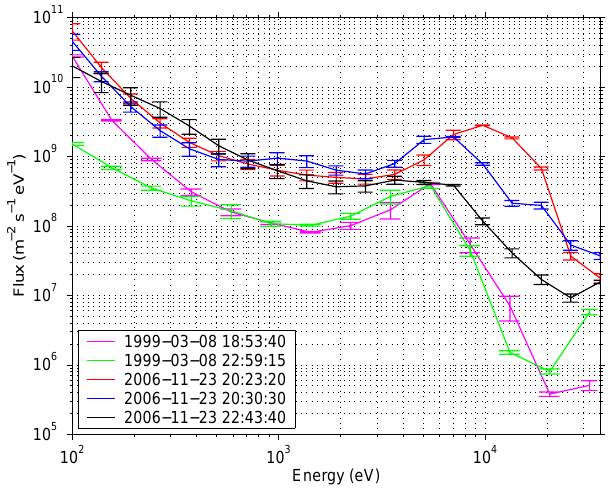
Fig. 5. Precipitating electron energy spectra derived from the EIS- CAT electron density profiles at the times shown. Error bars on each curve indicate the one standard error